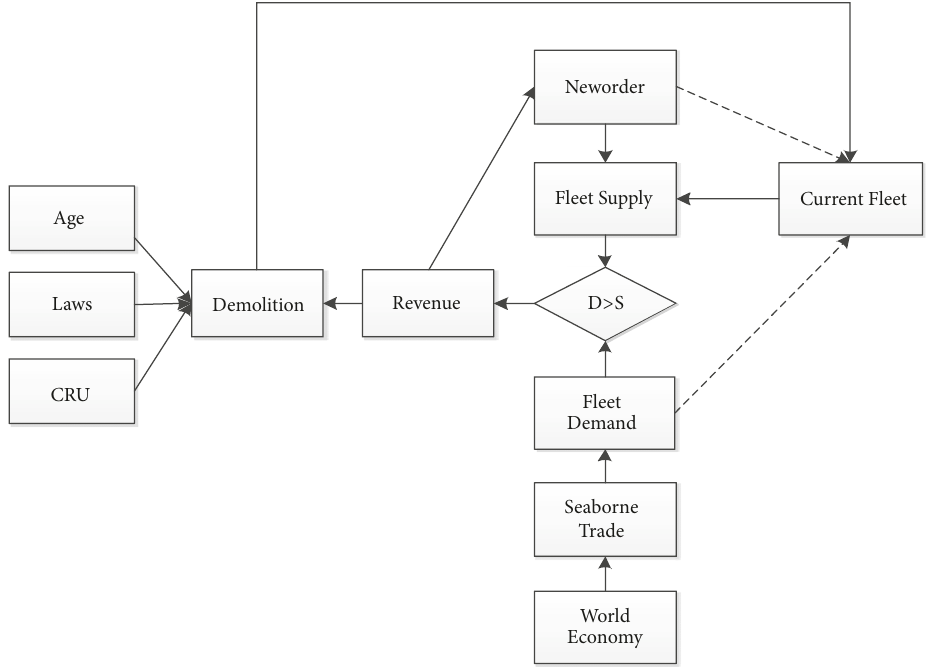
Figure 1: Dynamic analysis of shipping market . Note: CRU represents the steel price